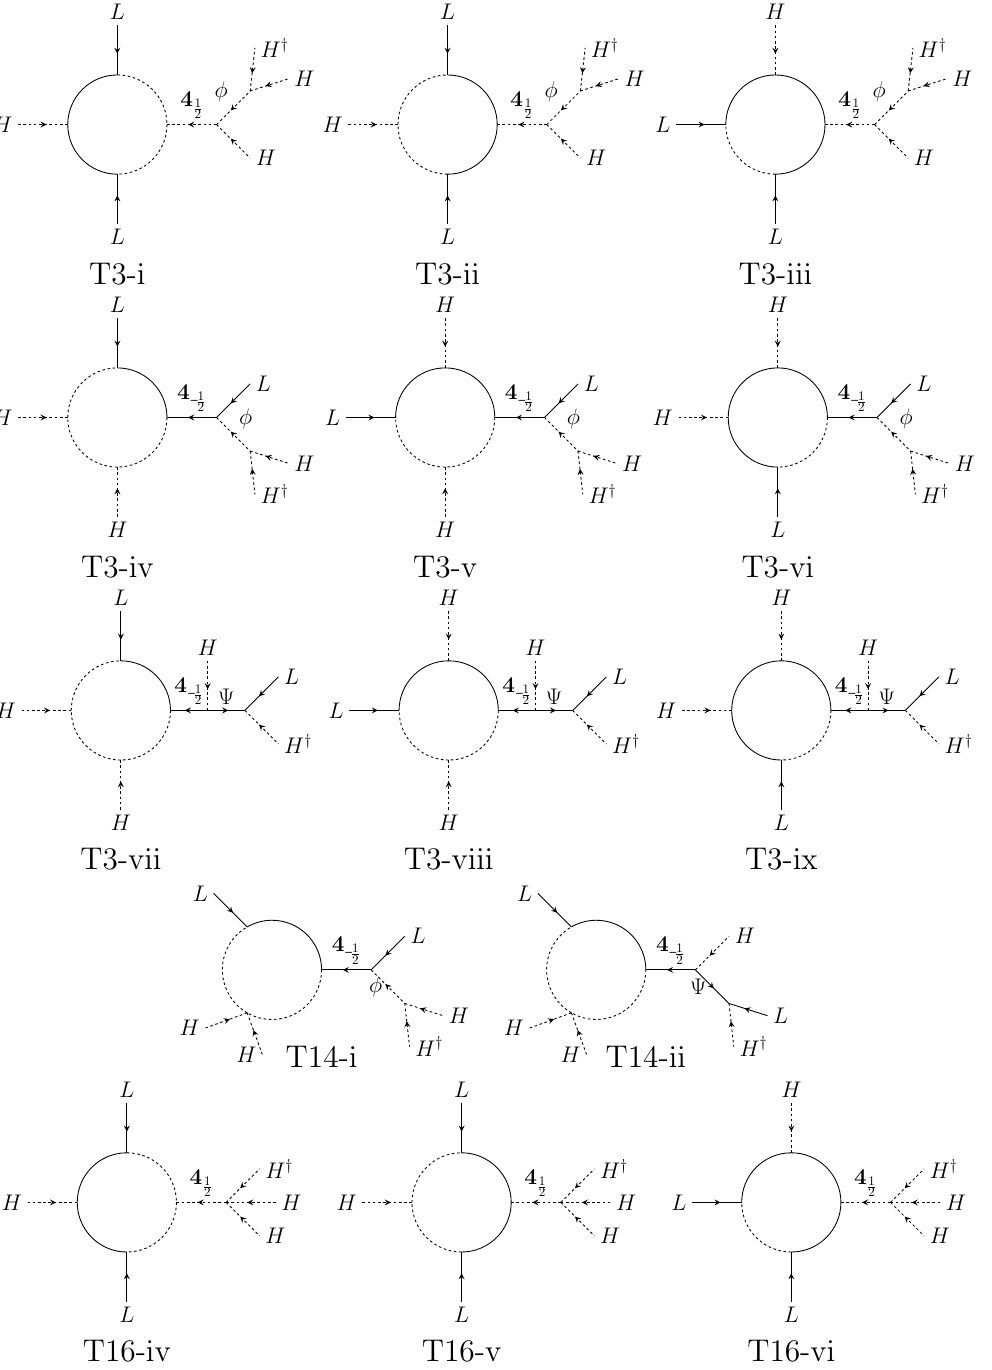
Figure 20 . All remaining diagrams that lead to a genuine d = 7 1-loop neutrino mass for which the maximum representations of SU(2) L is at least a quadruplet. In these diagrams, two quadruplets are needed. Along with the external fermion or scalar quadruplet, a genuine models needs an internal quadruplet to allow to distinguish between a 4 S